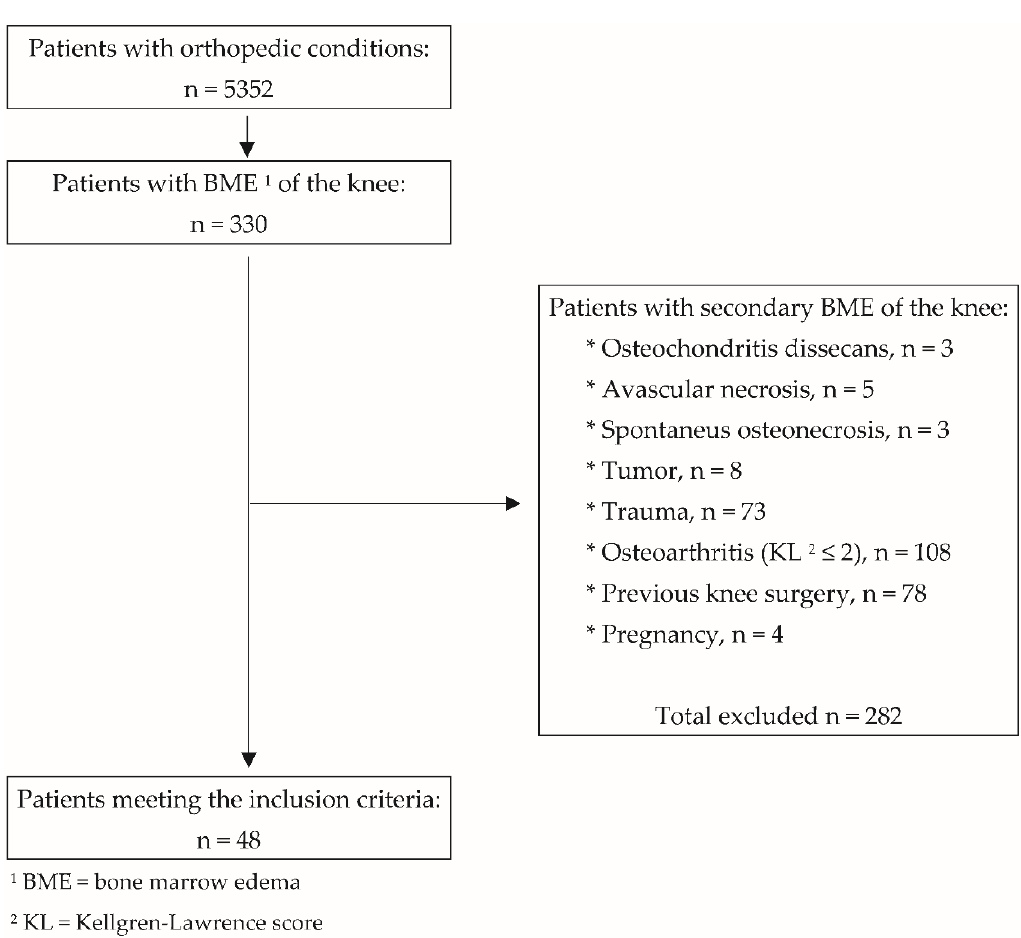
Figure 3. Patient selection protocol according to the inclusion and exclusion